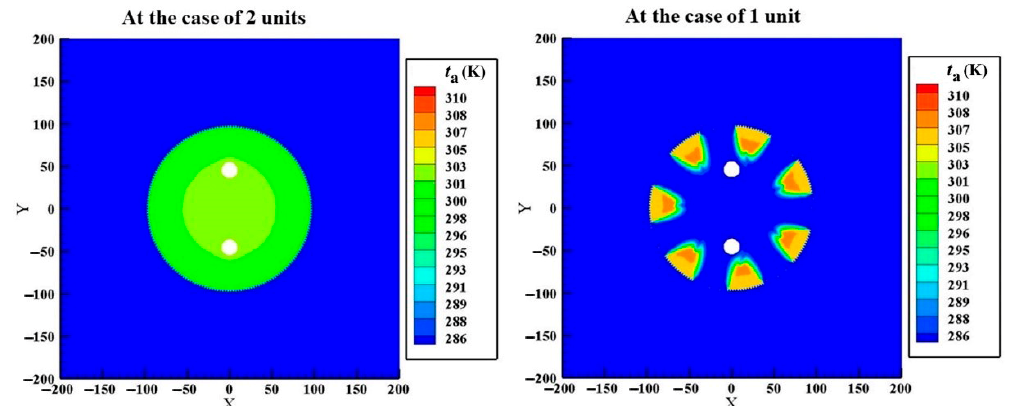
Figure 11. Comparison of temperature fields of ACHE in the absence of wind in the cases of 2 units and 1 unit.